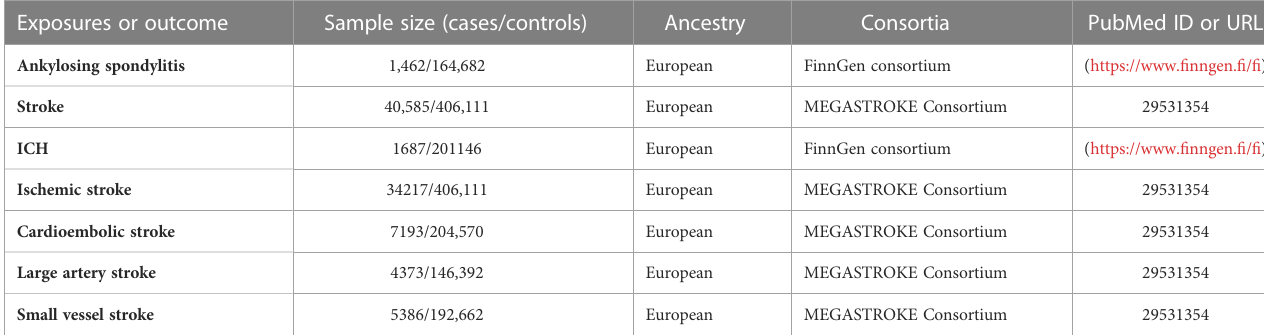
TABLE 1 Data sources and demographic pro fi les.